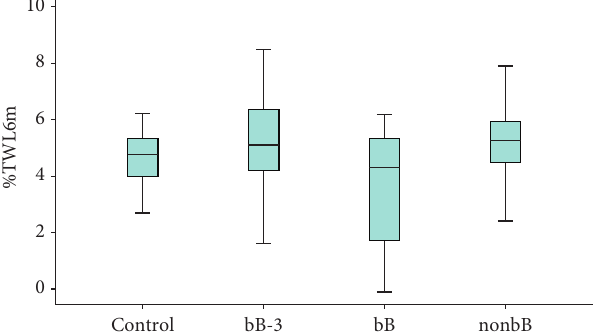
Figure 2: Percentage of total weight loss (TWL%) after 6 months in the 4 groups: after 6 months, we found a lower TWL% in bB (3.62 ± 1.96 versus 5.27 ± 1.76 in the bB-3 group, versus 5.15 ± 1.30 in the non-bB group, and versus 4.69 ± 0.87 in the control group).